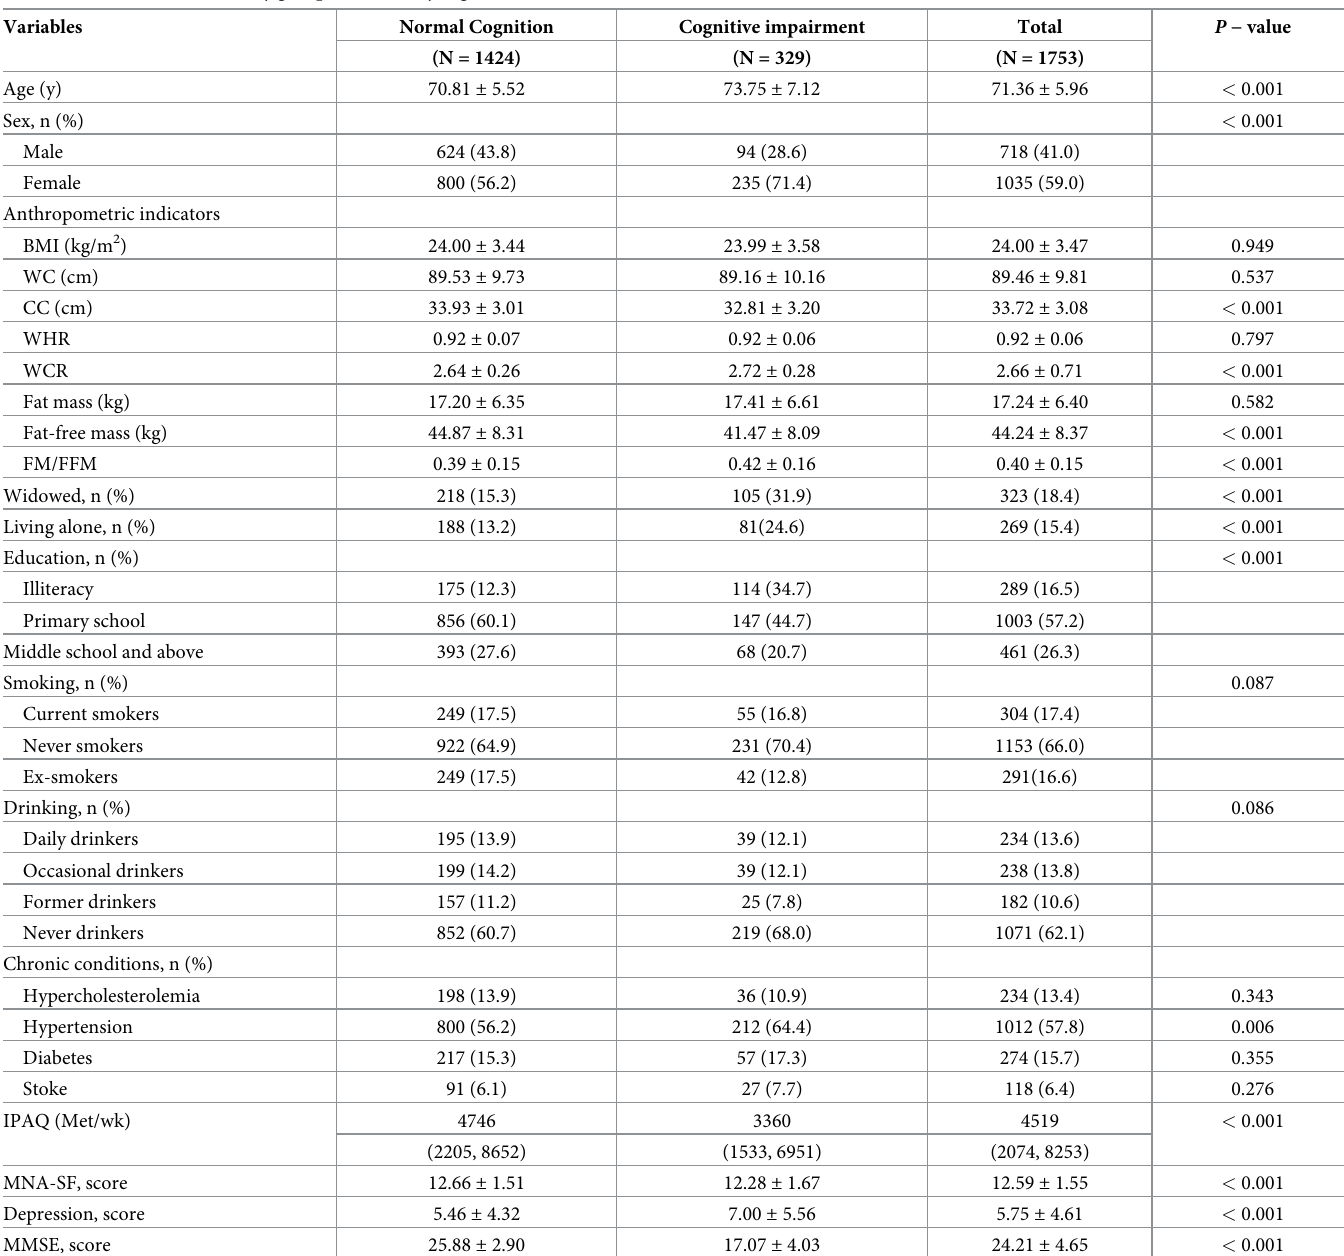
Table 1. Characteristics of study group, stratified by cognitive